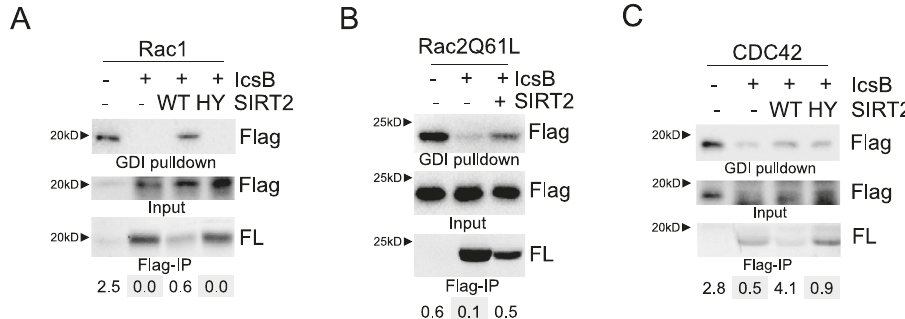
Fig. 5 | SIRT2 -catalyzed defatty-acylation promotes Rho GTPases and RhoGDI interaction. ThedisruptionofRhoGTPasebindingtoRhoGDIbyIcsBisrescuedby SIRT2. HEK293T cells were transfected with plasmids encoding indicated proteins: IcsB,SIRT2WTorHYmutant,andFlag-taggedRac1( A ),Rac2( B )orCDC42( C ).Cell lysates for each sample were subjected to GST-RhoGDI pulldown assay (shown in